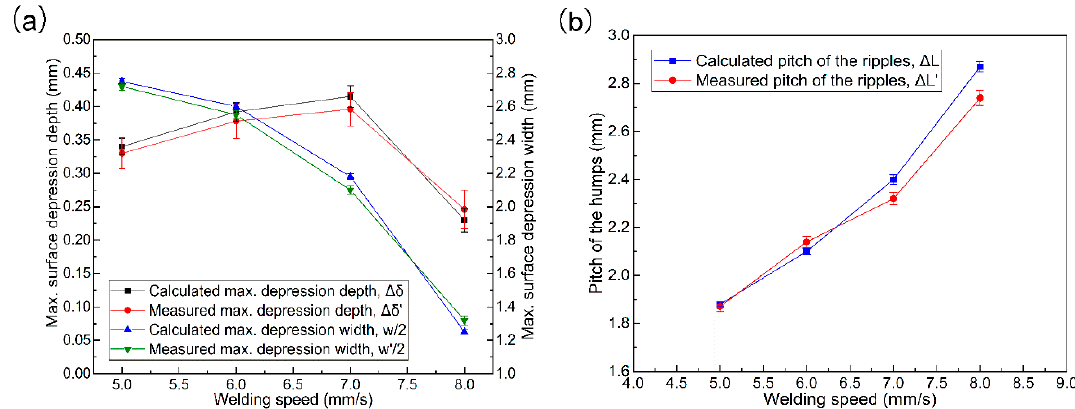
Figure 11. Calculated profiles of the weld pool depression with different welding speed: ( a ) weld pool depression, and ( b ) pitch of the humps.